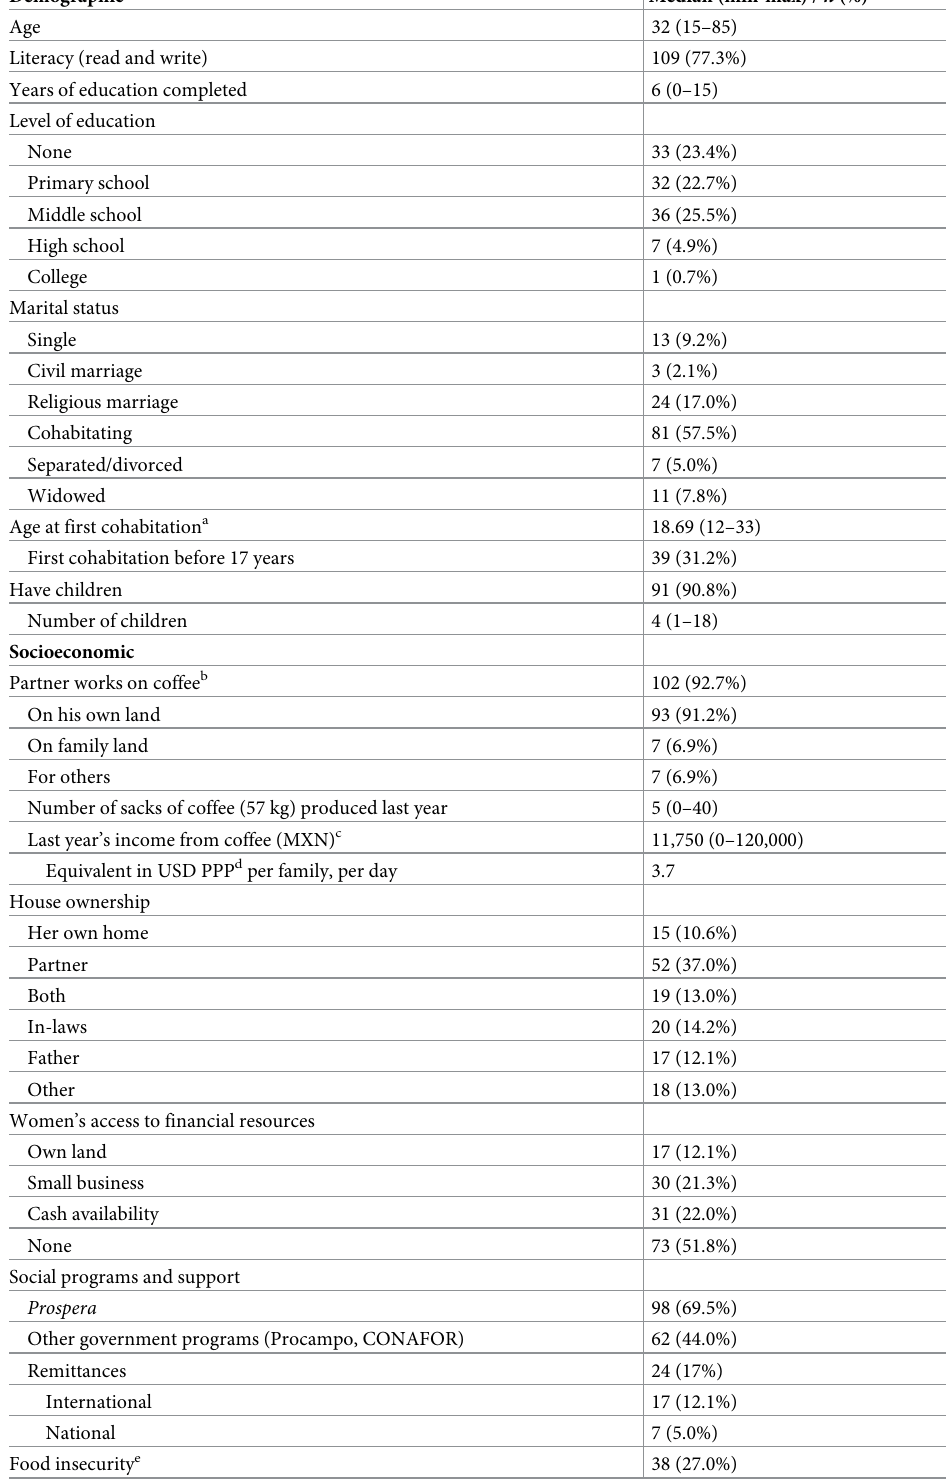
Table 1. Demographic and socioeconomic characteristics ( n =